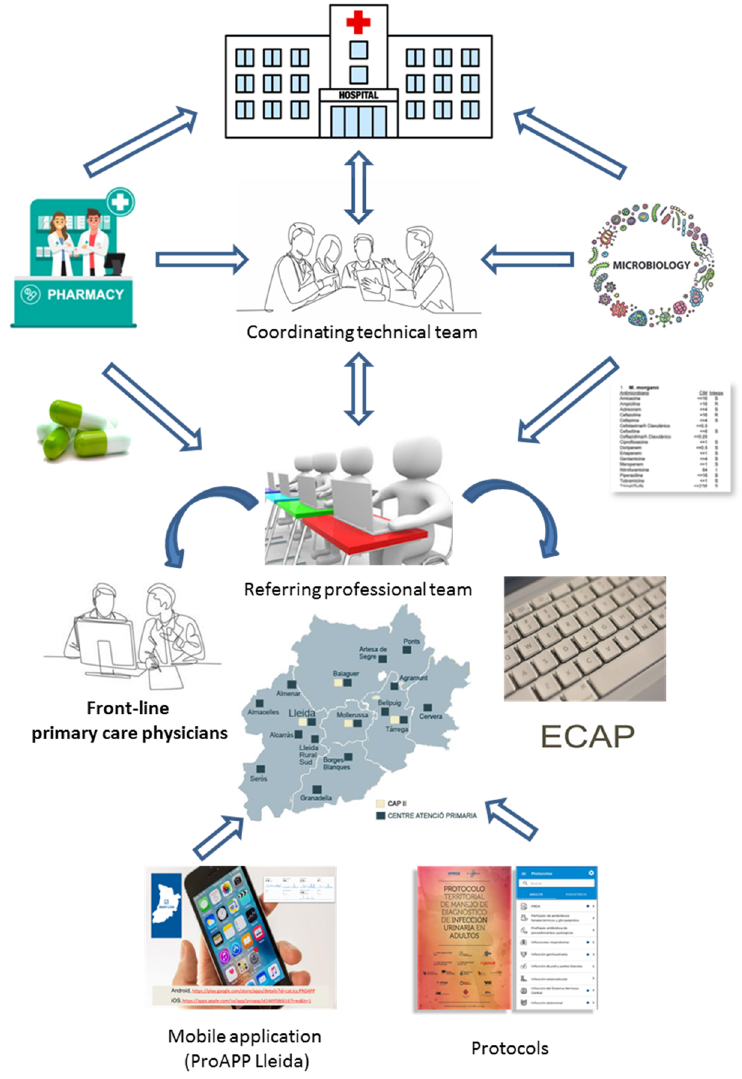
Figure 1. Organizational flow chart.